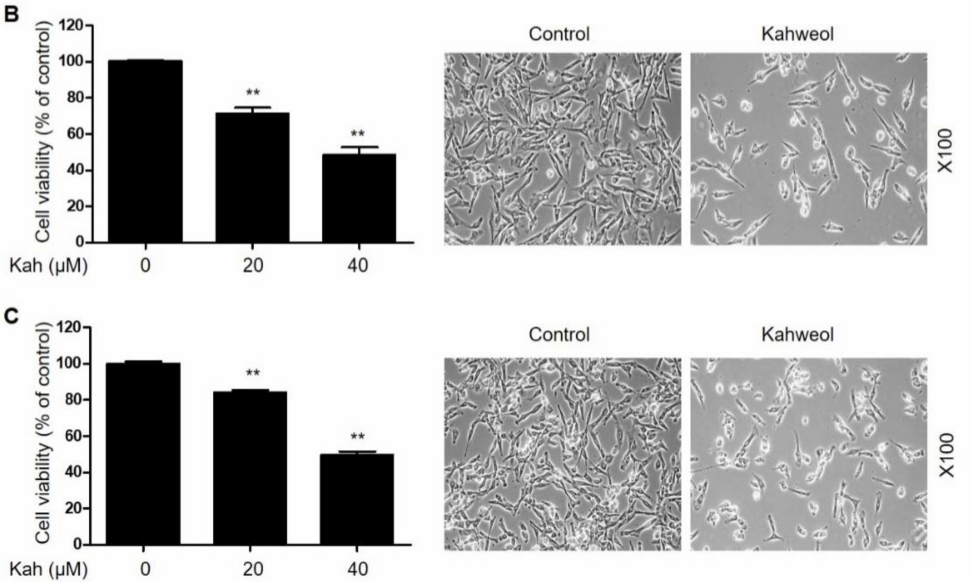
Figure 2. Anti-proliferative effects of kahweol in HCC cells. ( A ) Hep3B, ( B ) SNU182, and ( C ) SNU423 cells were treated with kahweol for 24 h. Cell viability was determined using a CCK-8 assay, and cell morphology was analyzed using microscopy. Cell survival is shown as a percent of control (without kahweol). ** p < 0.01 relative to the control (without kahweol).